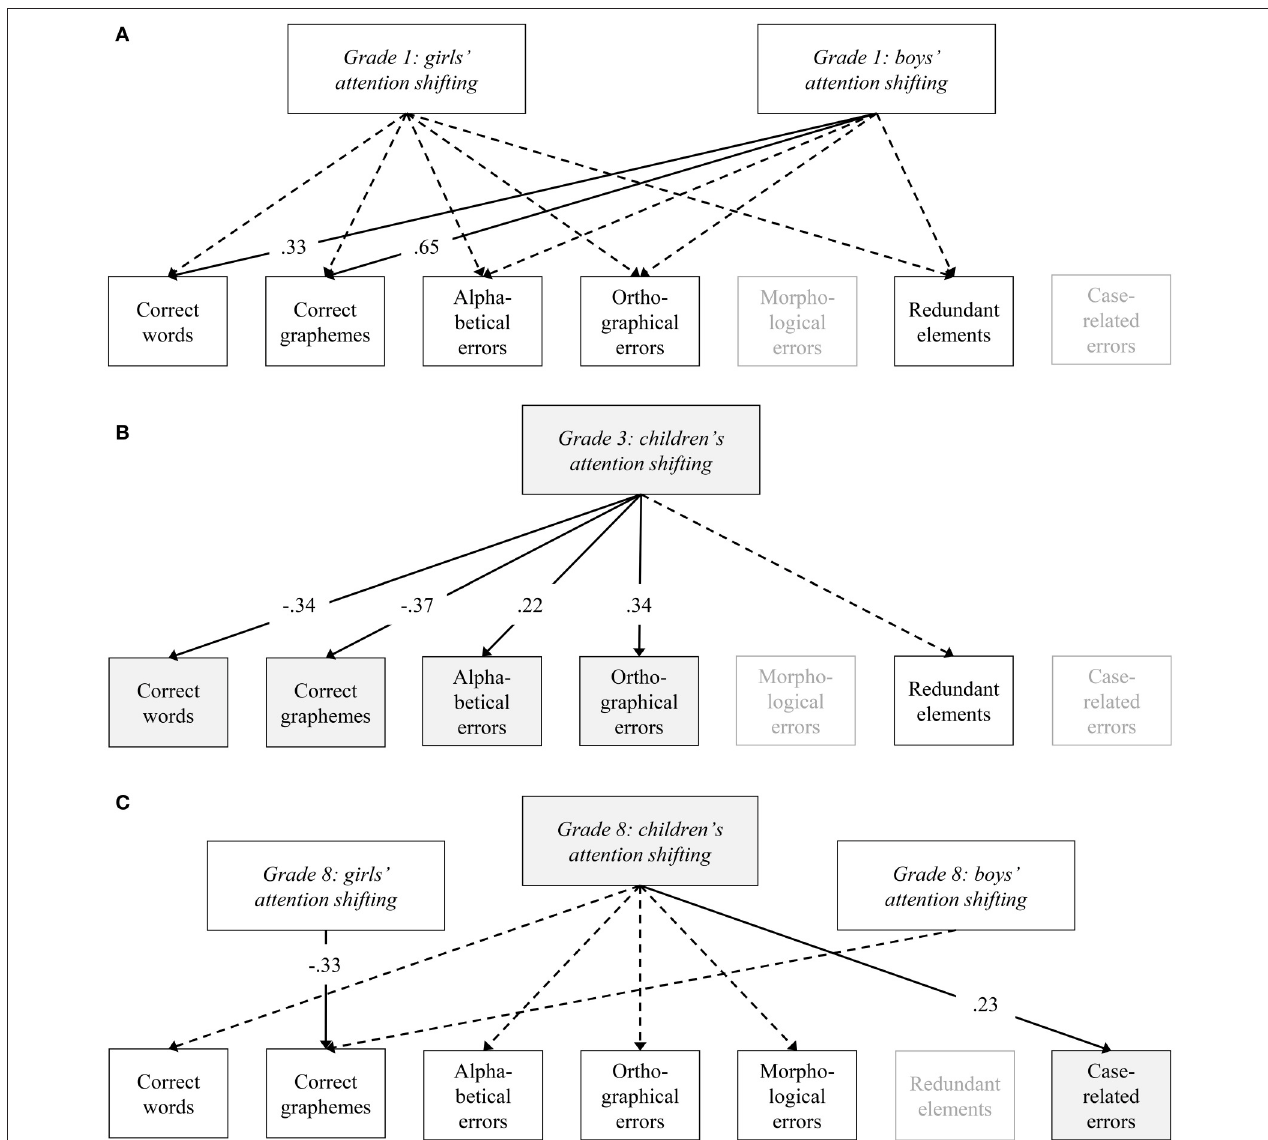
FIGURE 2 | (A) Favored structural full non-invariant model regarding gender for prediction of orthographic competences in grade 1. (B) Favored structural full invariant model regarding gender for prediction of orthographic competences in grade 3. (C) Favored structural partial invariant model regarding gender for prediction of orthographic competences in grade 8. (A–C) Structural gender invariance was tested using Bayes estimation. Analyses control for child age, gender, and migration background. Solid lines indicate meaningful relations (standardized coefficients), each with a Bayesian Credibility Interval excluding zero (see Tables 1 – 4 ). Gray boxes highlight gender invariant